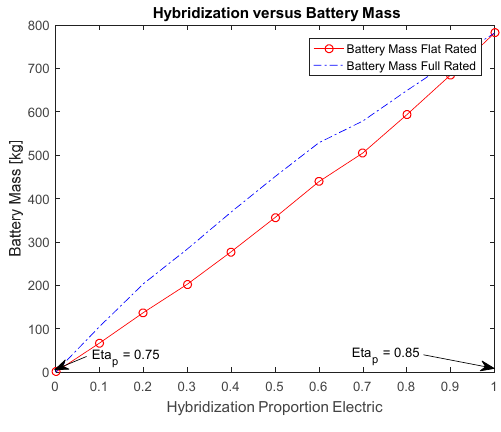
Figure 9. Battery mass requirements.